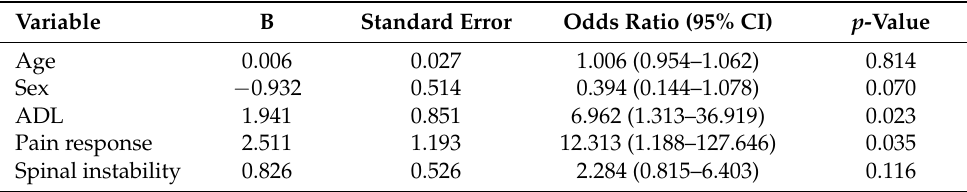
Table 5. Factors affecting physical function.